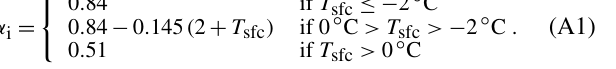
Figure A1. Sea-ice albedo resulting from the modified Køltzow scheme (Køltzow, 2007) depending on the ice surface temperature and thickness. Thereby the threshold thickness above which a snow cover of 10cm is assumed is h c = 0.2m (bold black line). In addi- tion the melt pond fraction is shown as a function of the ice tem- perature (bold green line) and the resulting modification (dashed green line) of the sea-ice albedo (dashed black line). For bare sea- ice (thin black lines) a constant albedo value is assumed, which is linearly decreasing from 0.57 (Persson et al., 2002) at 20cm ice thickness (bold grey line) to 0.07 (ocean albedo; Perovich and Gren- fell, 1981), but constant over all surface temperatures, as shown in Eq. (A2). The vertical blue lines mark the transition range from cold to melting